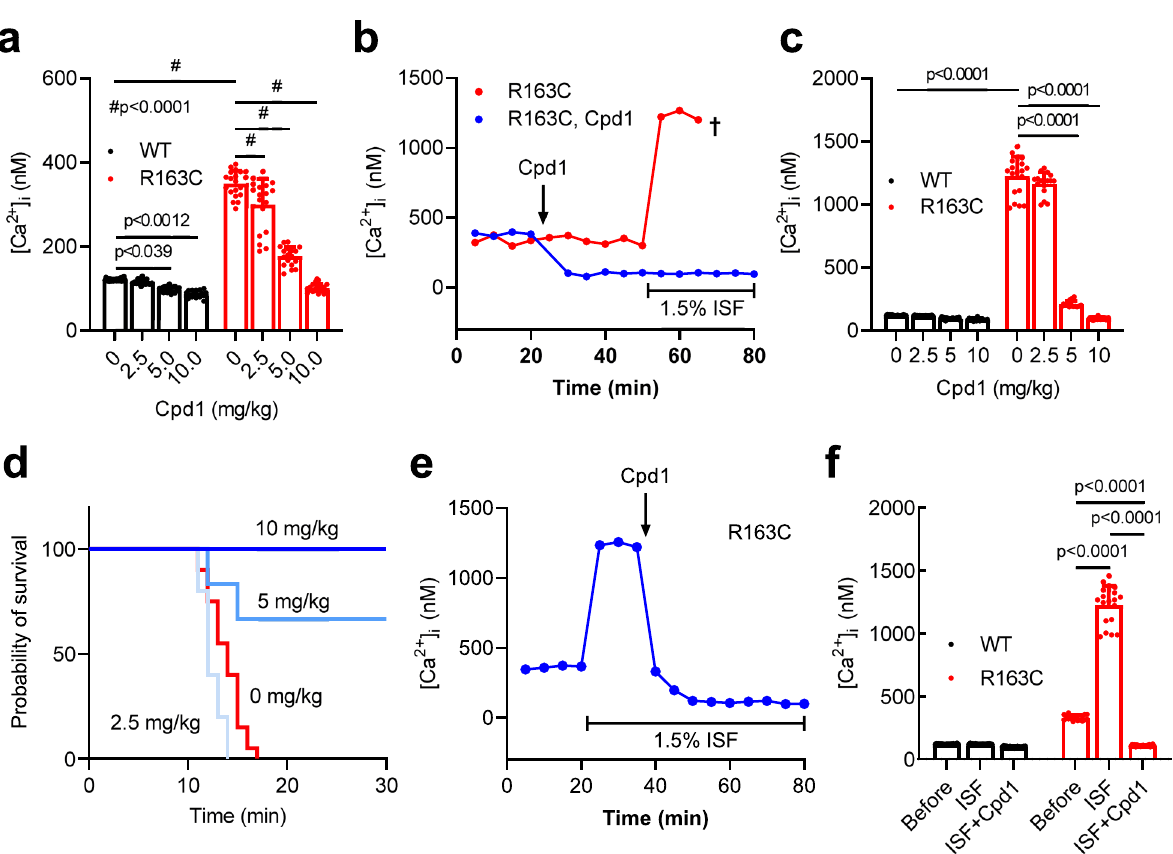
Fig. 7 Effect of Cpd1 on heterozygous RYR1-p.R163C (R163C) mice. Resting [Ca 2 + ] i in vastus lateralis muscle from R163C mice was determined in vivo by Ca 2 + selective microelectrode. a – d Preventive effect of Cpd1. a Effect of Cpd1 on resting [Ca 2 + ] i in WT and R163C mice with no stimulus. Data are shown as means± SD (0mg/kg: n = 20; 2.5 mg/kg: n = 16; 5 mg/kg: n = 19; 10mg/kg: n = 16 for WT and 0 mg/kg: n = 20; 2.5mg/kg: n = 18; 5 mg/kg: n = 18; 10 mg/kg: n = 19 for R163C) and were analyzed by two-way ANOVA with Tukey ’ s test. b Time course of [Ca 2 + ] i in R163C mice during iso fl urane challenge. Cpd1 (10mg/kg) was injected i.p. at 20min and iso fl urane was administered at 50min. c Effect of Cpd1 on resting [Ca 2 + ] i during 1.5% iso fl urane anesthesia. Data are shown as means± SD (0mg/kg: n = 18; 2.5mg/kg: n = 17; 5mg/kg: n = 17; 10mg/kg: n = 15 for WT and 0 mg/kg: n = 19; 2.5mg/kg: n = 15; 5 mg/kg: n = 16; 10mg/kg: n = 21 for R163C) and were analyzed by two-way ANOVA with Tukey ’ s test. Cpd1 dose-dependently reduced [Ca 2 + ] i in R163C mice to a level in WT mice. d Survival curves of R163C mice after iso fl urane anesthesia (0mg/kg: n = 20; 2.5mg/kg: n = 5; 5 mg/kg: n = 17; 10mg/kg: n = 9). Cpd1 dose-dependently increases the survival rate. e – f Rescue effect of Cpd1. e Resting [Ca 2 + ] i of R163C muscle was determined by Ca 2 + selective microelectrode. Iso fl urane was administered at 20min and Cpd1 (10mg/kg) was i.p. injected at 35min. f Summary of resting [Ca 2 + ] i before (Before) and after exposure to iso fl urane (ISF) and after addition of Cpd1 (ISF + Cpd1) in WT and R163C muscles. Cpd1 effectively reduces [Ca 2 + ] i in R163C muscles to the level in WT muscles. Data are shown as means±SD (Before: n = 20; ISF: n = 18; ISF + Cpd1: n = 16 for WT and Before: n = 17; ISF: n = 19; ISF + Cpd1: n = 20 for R163C) and were analyzed by two-way ANOVA with Tukey ’ s test. Source data are provided as a Source Data fi